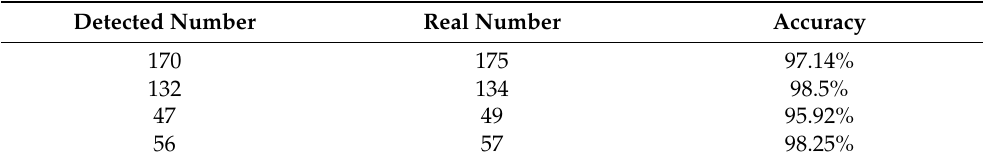
Figure 4. Detection results of some example images. ( a , b ) are from HRED dataset. ( c , d ) are from GWHD dataset. Table 3. Detected and real numbers of wheat